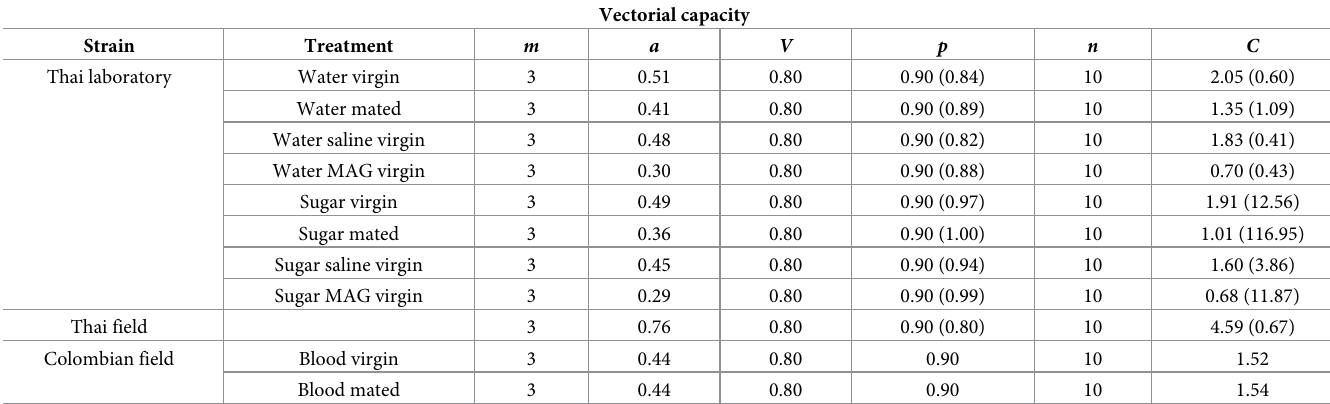
Table 2. Vectorial capacity estimates in both experimental laboratory Thai strain and field-derived Colombian strain(s).